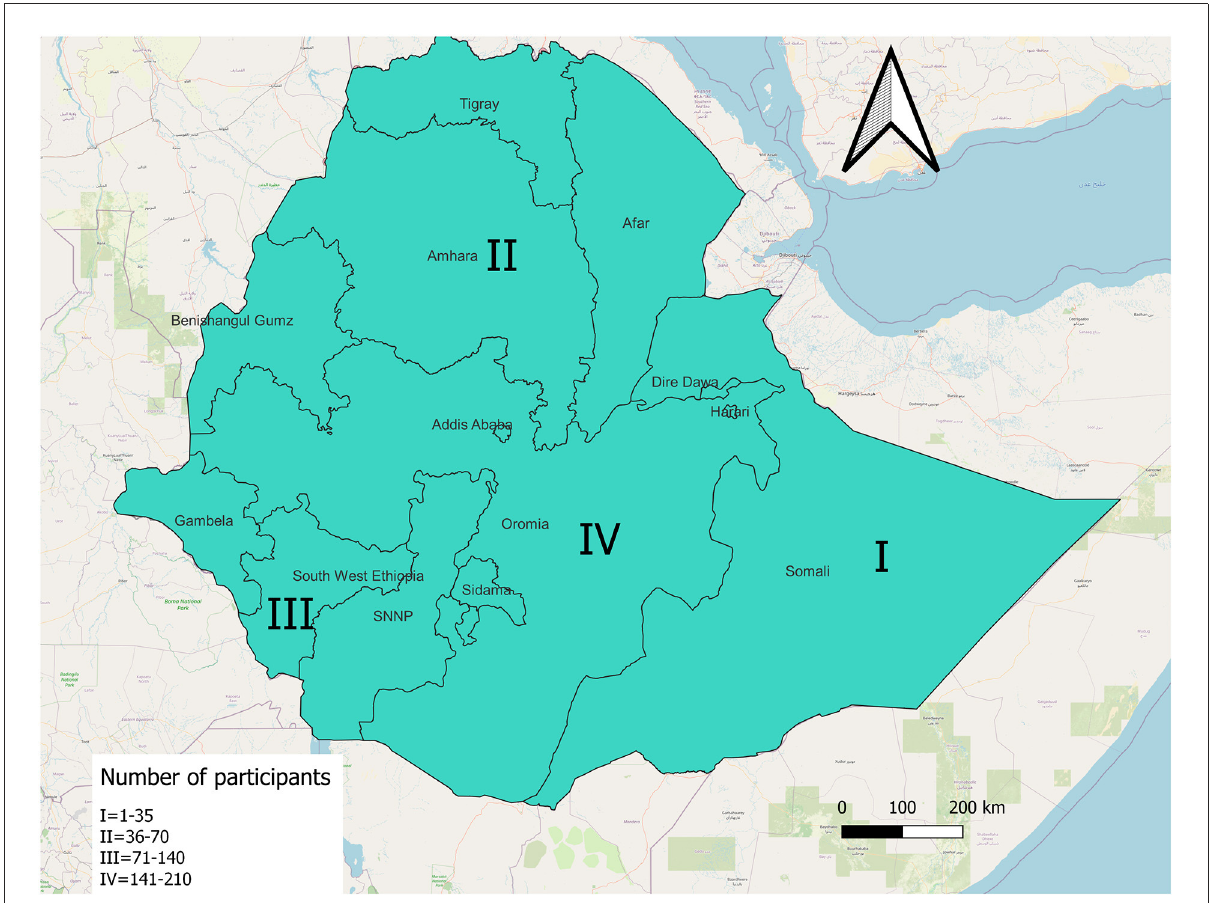
FIGURE1 Study setting of self-reported side effects of COVID-19 vaccines, Ethiopia,